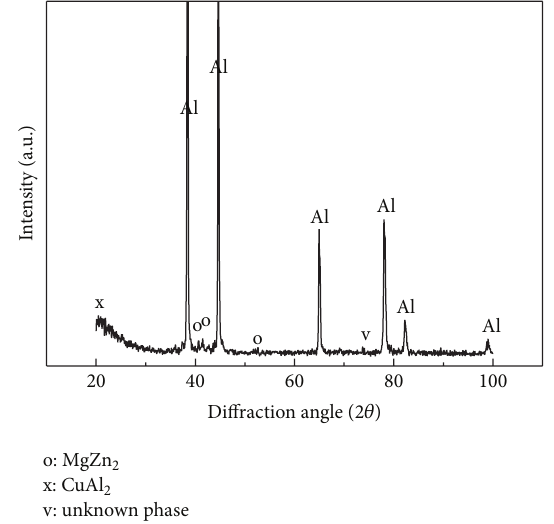
Figure6:X-raydiffractionpatternofsinteredAlumix431Dpowder.